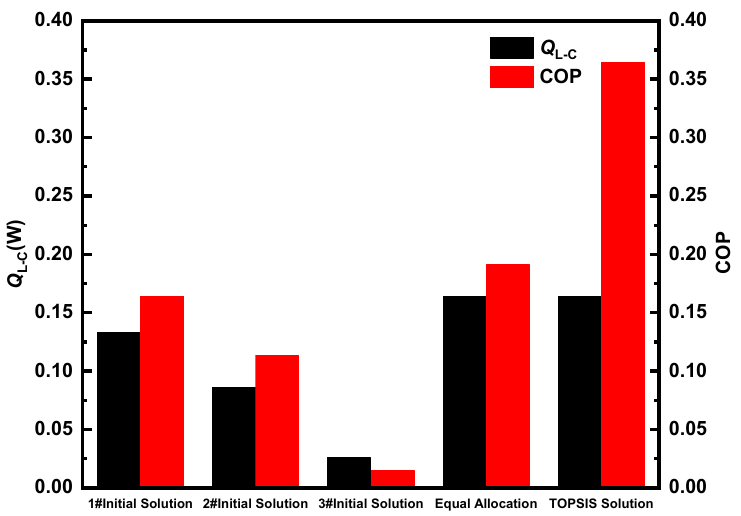
Figure 11. Performance metrics comparison between the three initial solutions, the equal allocation design, and the optimized design. Table 4. Parameters and performances comparison between the Initial Solutions, Equal Allocation, and TOPSIS Solution.